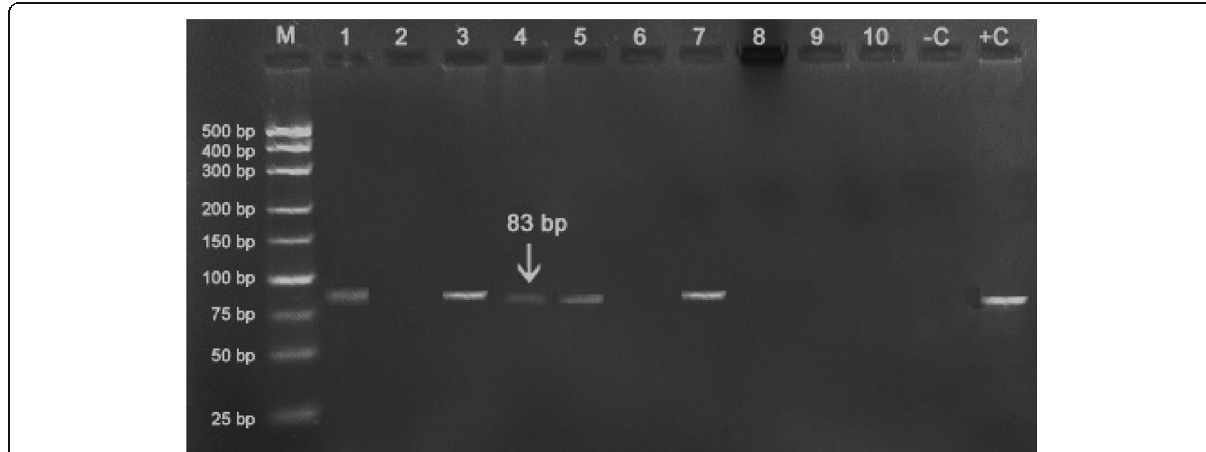
Fig. 2 Different PCR products representing donkey species adulteration of beef meat products. Lane M is 25 – 500 bp ladder or size marker. Beef burger samples (lanes 1, 2 and 3), beef kofta samples (lanes 4, 5 and 6), and oriental beef sausage (lanes 7, 8, 9 and 10). − C and +C are negative and positive controls for chicken meat, respectively. Positive result is indicated by a band of 83 bp of mitochondrial 12S rRNA gene amplification for donkey